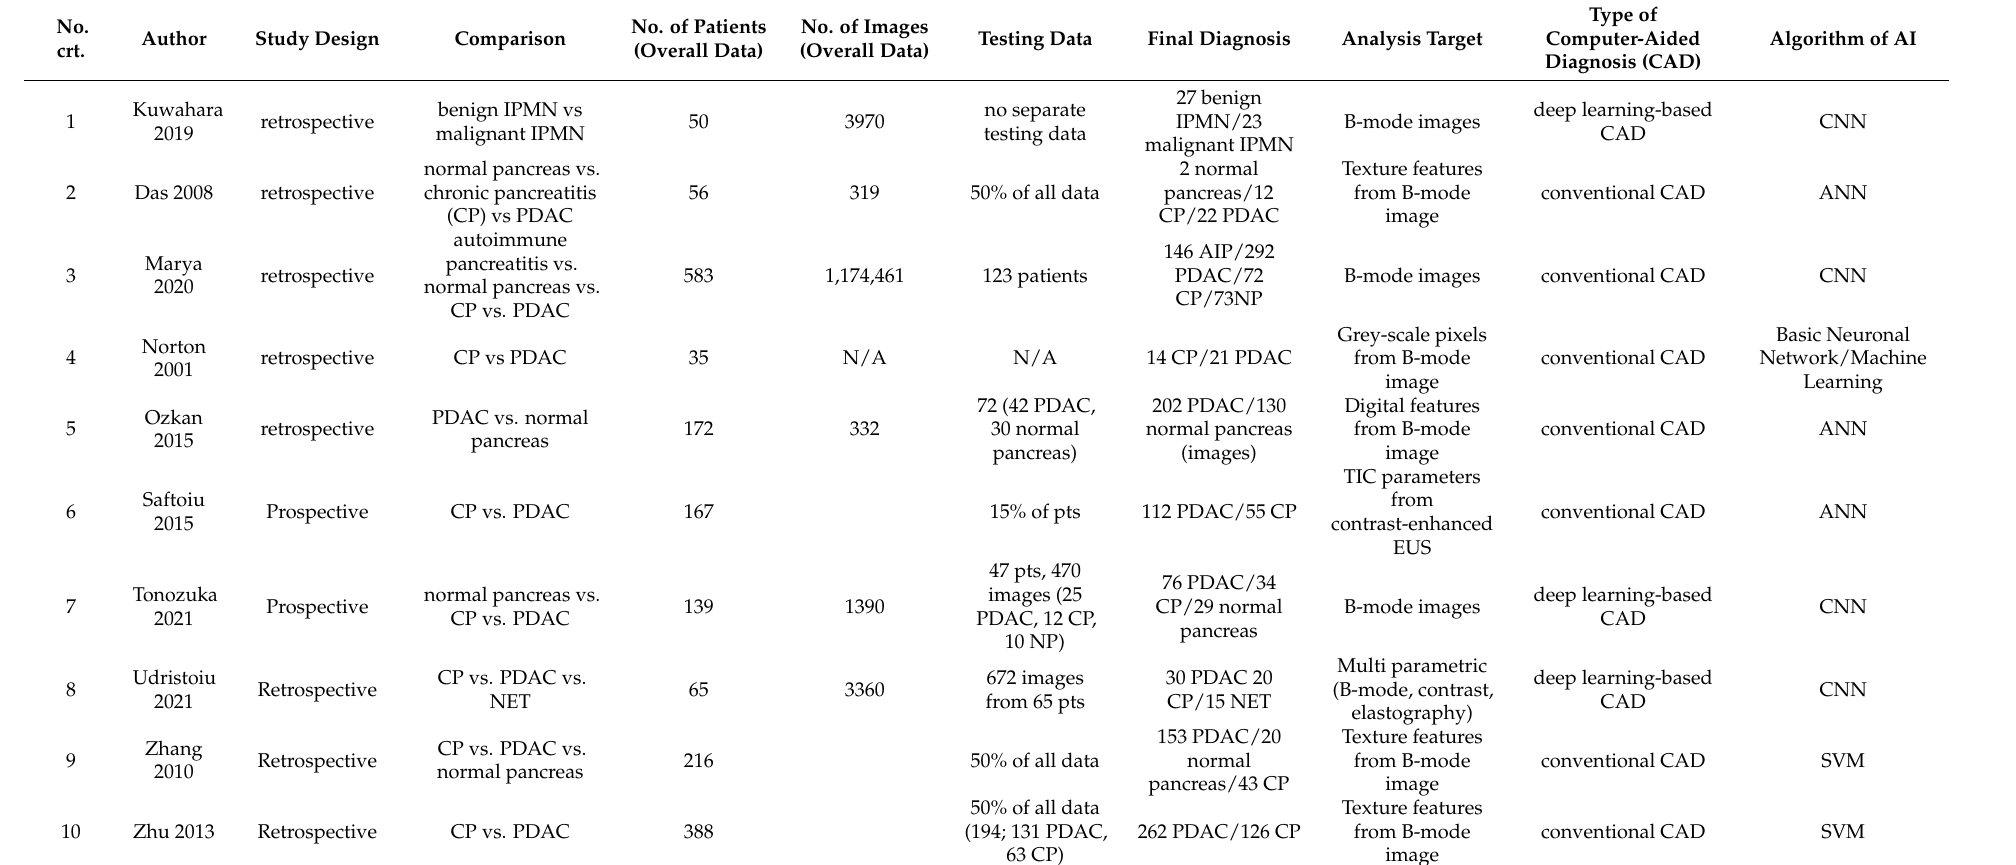
Table 1. The main characteristics of the included studies in the